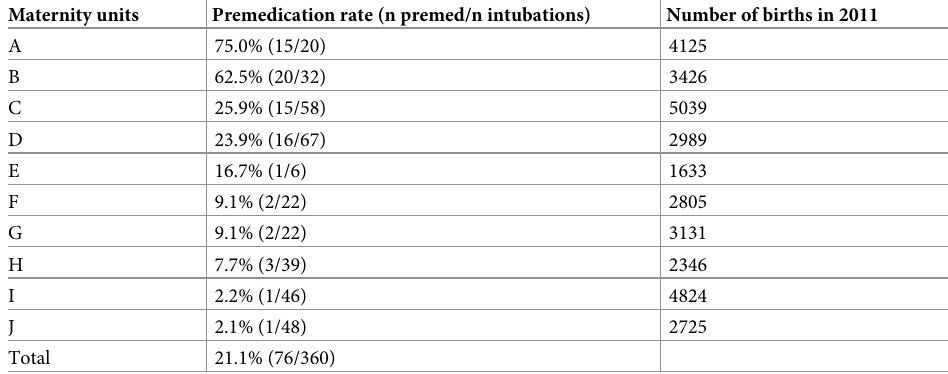
Table 1. Premedication rates and number of births in 2011 in the 10 centers that performed at least one premedication. Maternity units